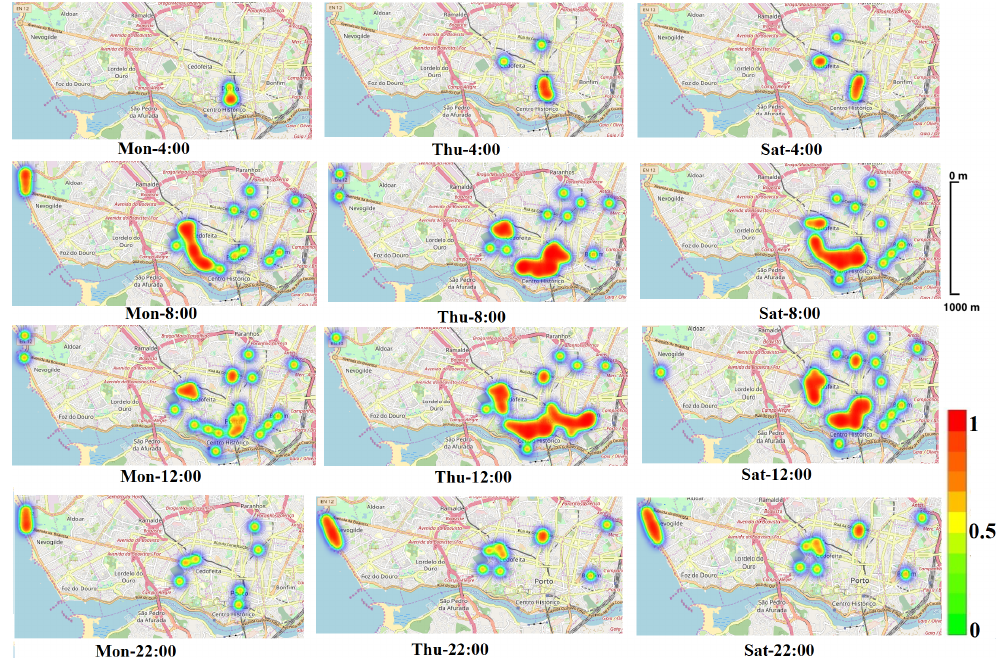
Figure 7. Trajectory density prediction at different times of different